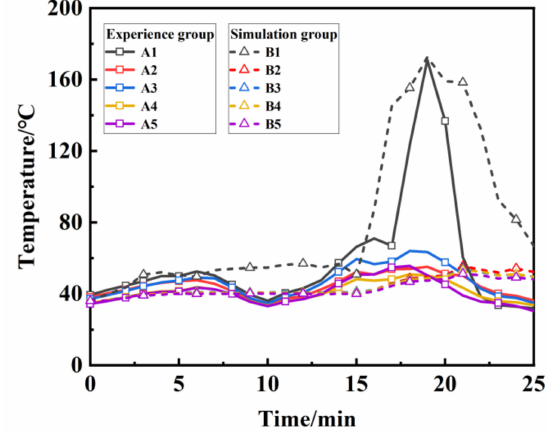
Figure 4. The temperature change curve with time.